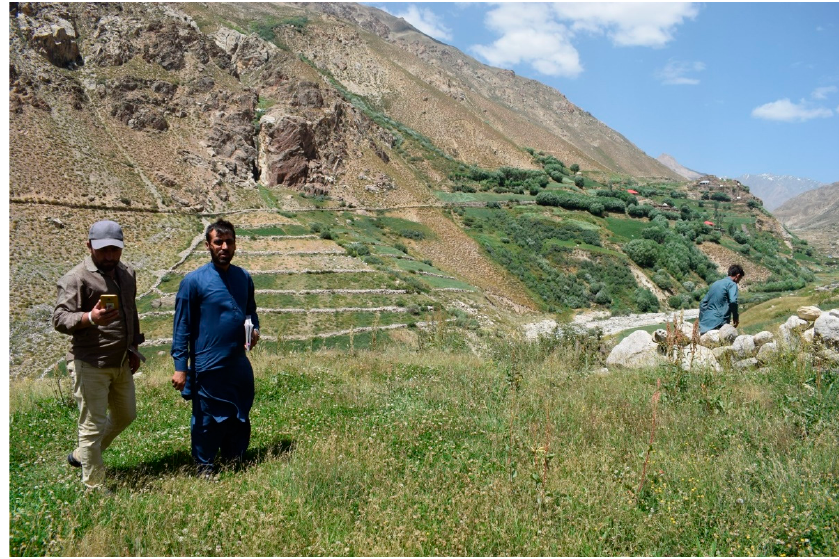
Figure 1. The author during a visit to a remote mountain Valley in Chitral. communities were Allium carolinianum Redout é , Amaranthus spp., Chenopodium album L., Asphodelus tenuifolius Cav., Carum carvi L., Descurainia sophia (L.) Webb ex Prantl, Eremurus sp., Goldbachia laevigata DC., Lepidium draba subsp. Chalepense (L.) P.Fourn., Malcolmia africana (L.) W.T. Aiton, Portulaca oleracea L., Rumex dentatus L., Silene conoidea L. Allium spp., Portulaca spp., Urtica dioica L. Taraxacum campylodes G.E. Haglund (see [1–6]). I also cross-